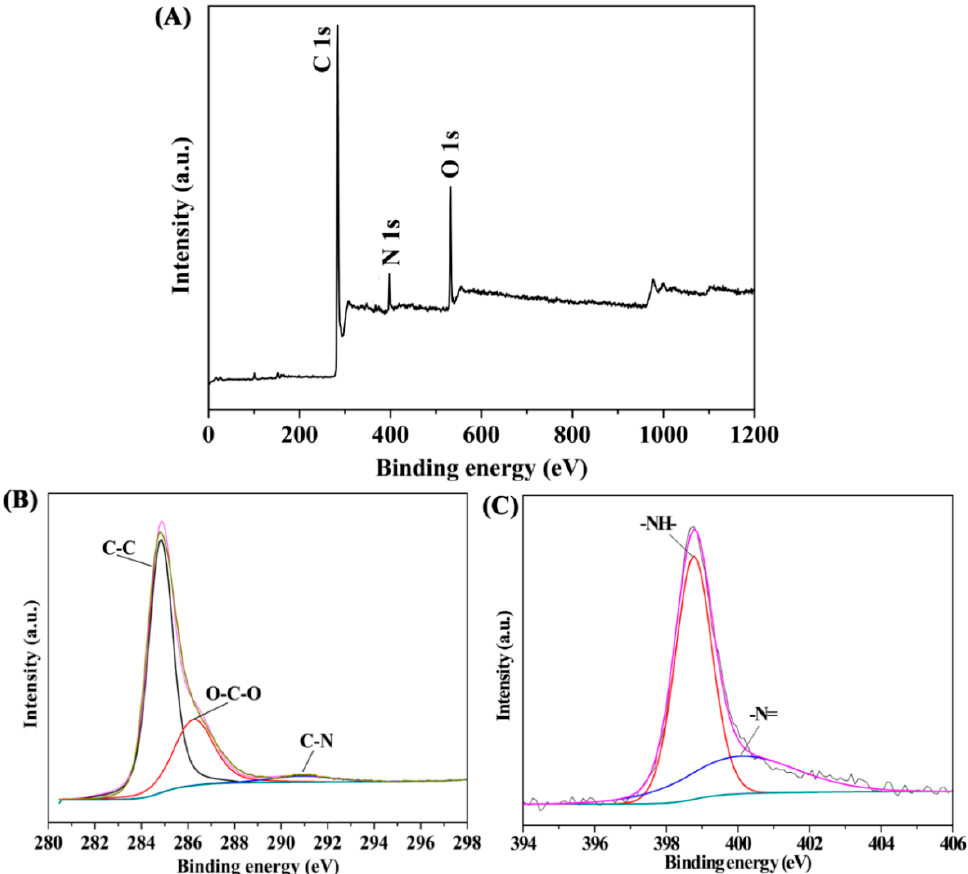
Figure 5. X-ray photoelectron spectroscopy (XPS) spectra of CuFe 2 O 4 / Ag@COF: ( A ) full survey spectrum, ( B ) C 1s, and ( C ) N 1s regions.